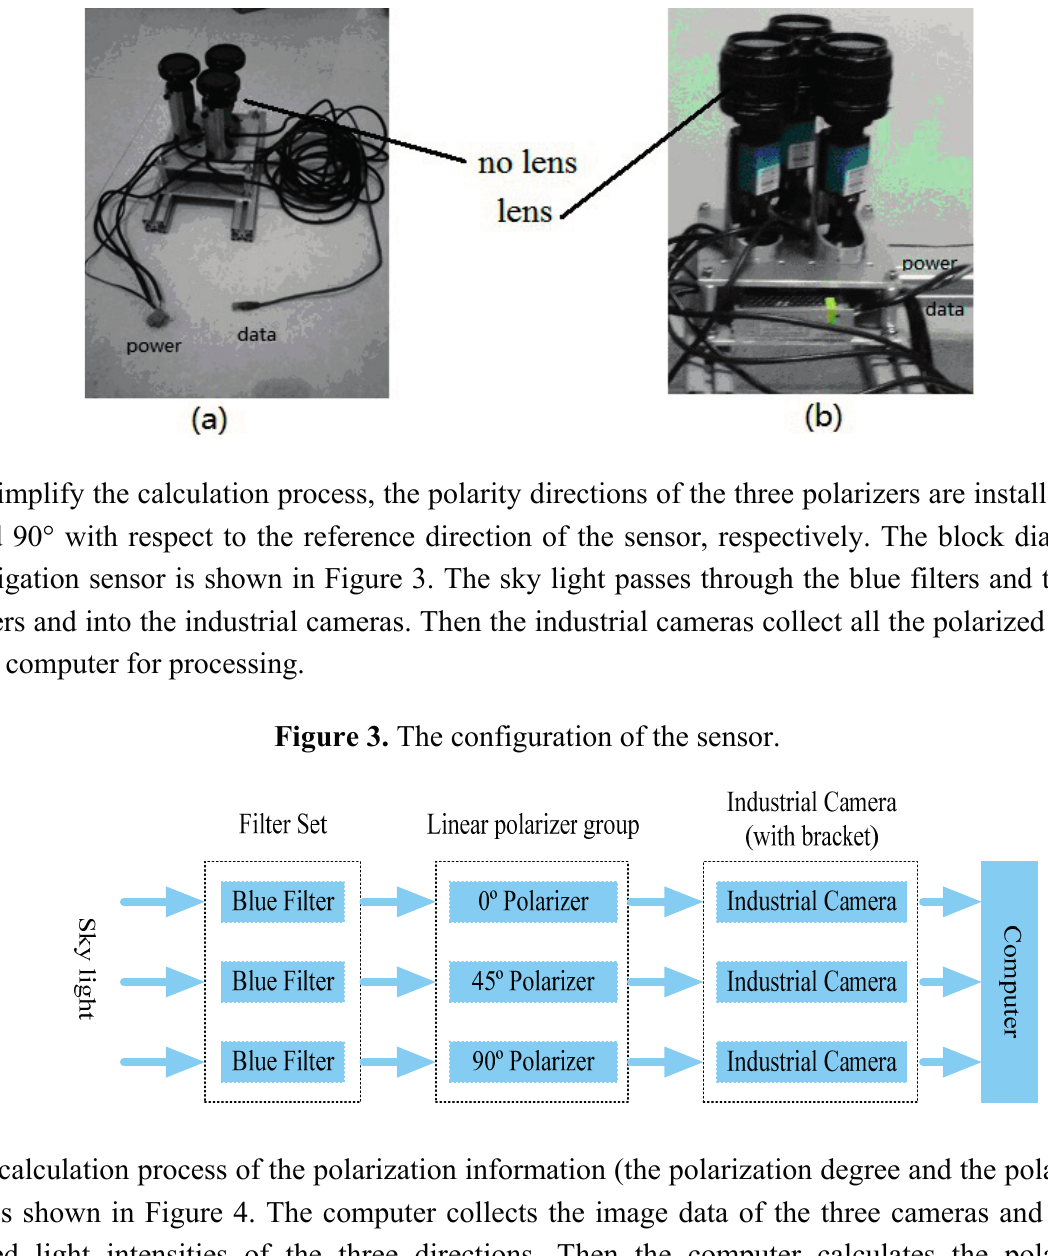
Figure 2. The polarization navigation sensor.